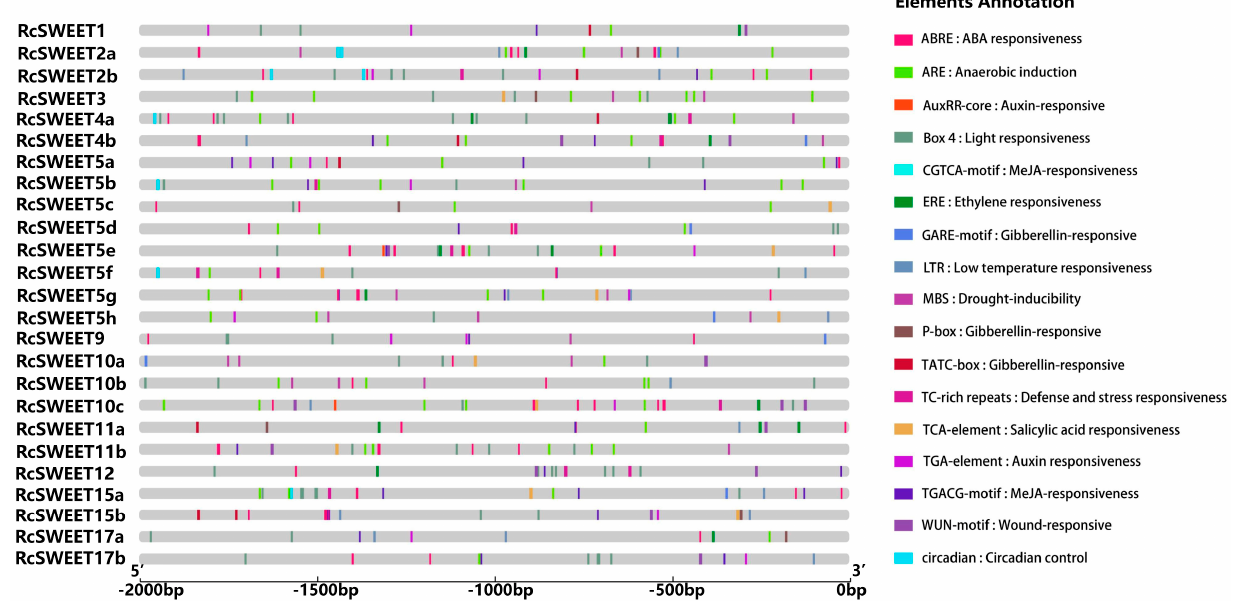
Figure 4. Predicted cis-elements in the promoters of the RcSWEET genes. Promoter sequences ( − 2000 bp) of 25 RcSWEET genes were analyzed by PlantCARE. Seventeen stress-relevant cis-acting elements are indicated in different colored boxes.